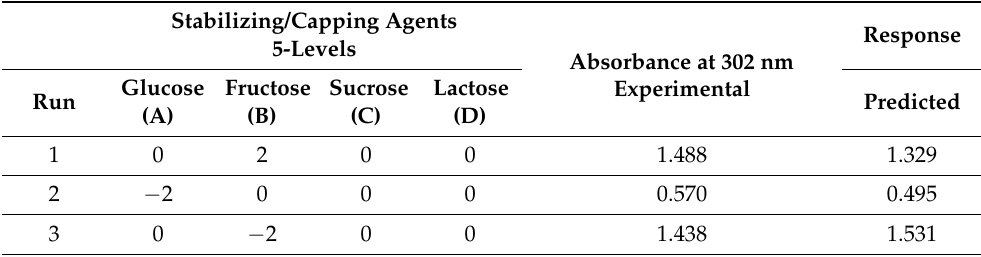
Table 1. SCD with four components (A, B, C, D) with none process